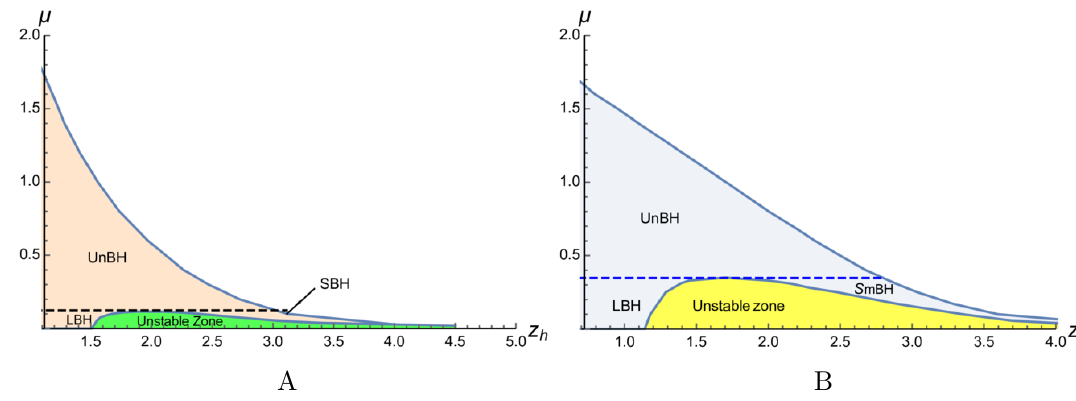
Figure 31 . Stability zones at the ( z h ; (cid:22) )-plane of the blackhole isotropic (A) and anisotropic (B) backgrounds. Here SBH indicates the regions of small black holes, LBH indicates the regions of large black holes, and UnBH indicates the regions of parameters where is no separation on the small and large black